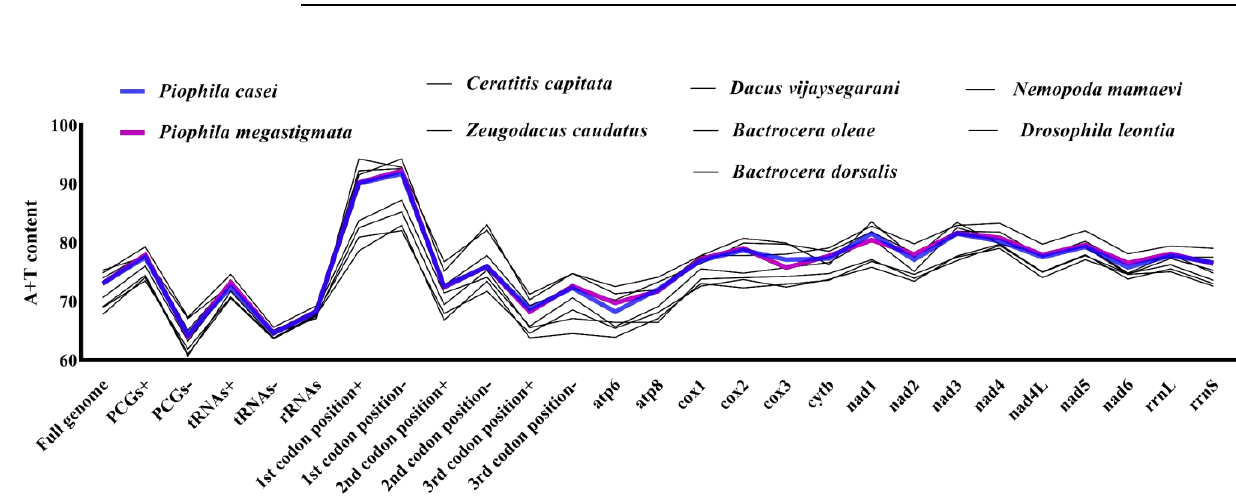
Figure 2. AT content of genes in various parts of the mt genome among the nine species in Tephritoidea. Table 1. The base composition of the complete mt genome of P. casei and P. megastigmata .